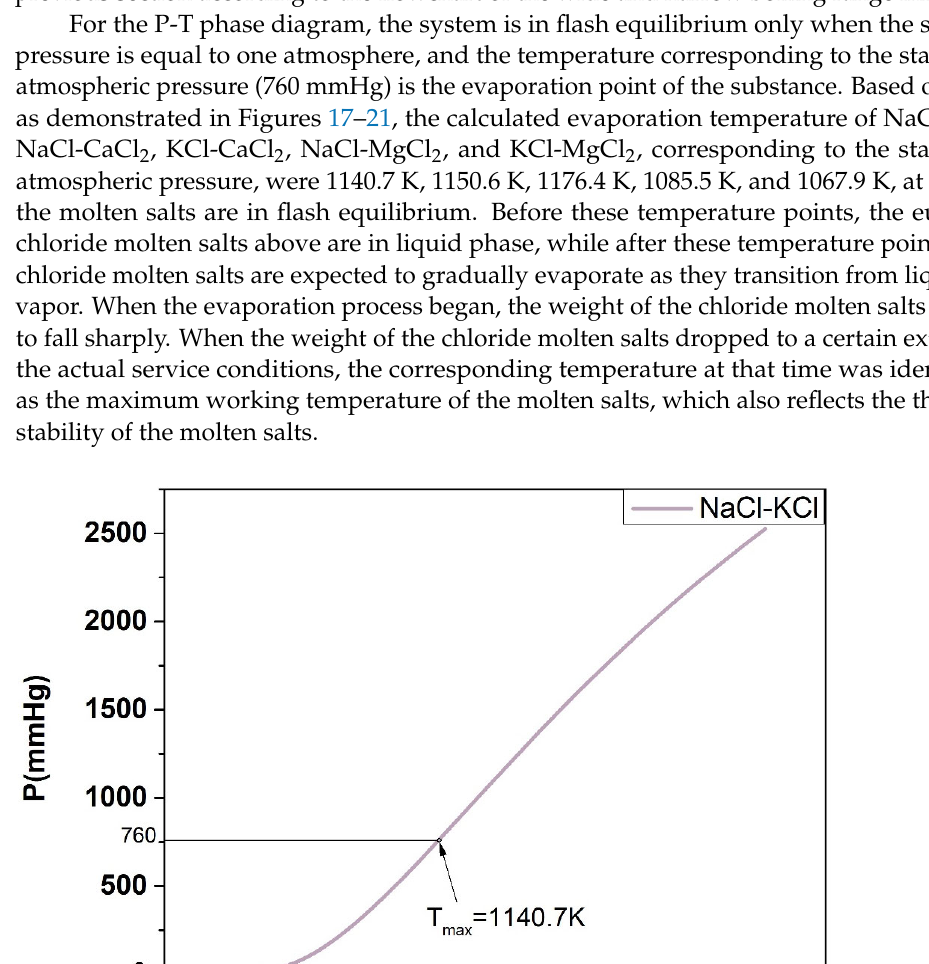
Figure 18. Calculated P ‐ T phase diagram of the NaCl ‐ CaCl 2 binary system.